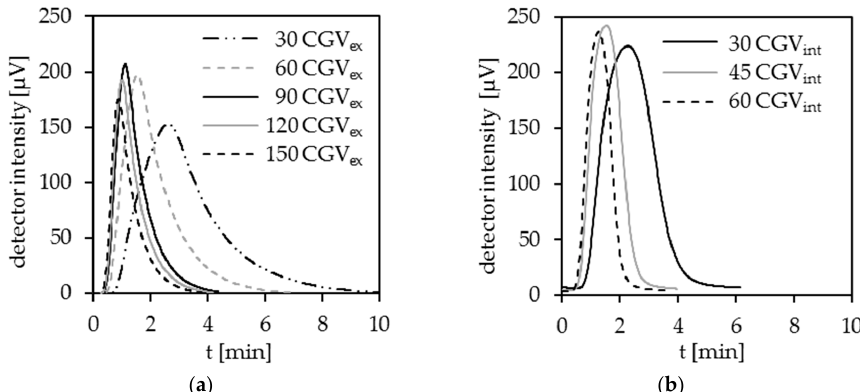
Figure 3. ( a ) CO 2 transport with external carrier gas; ( b ) CO 2 transport with internal carrier gas; HNO 3 ,